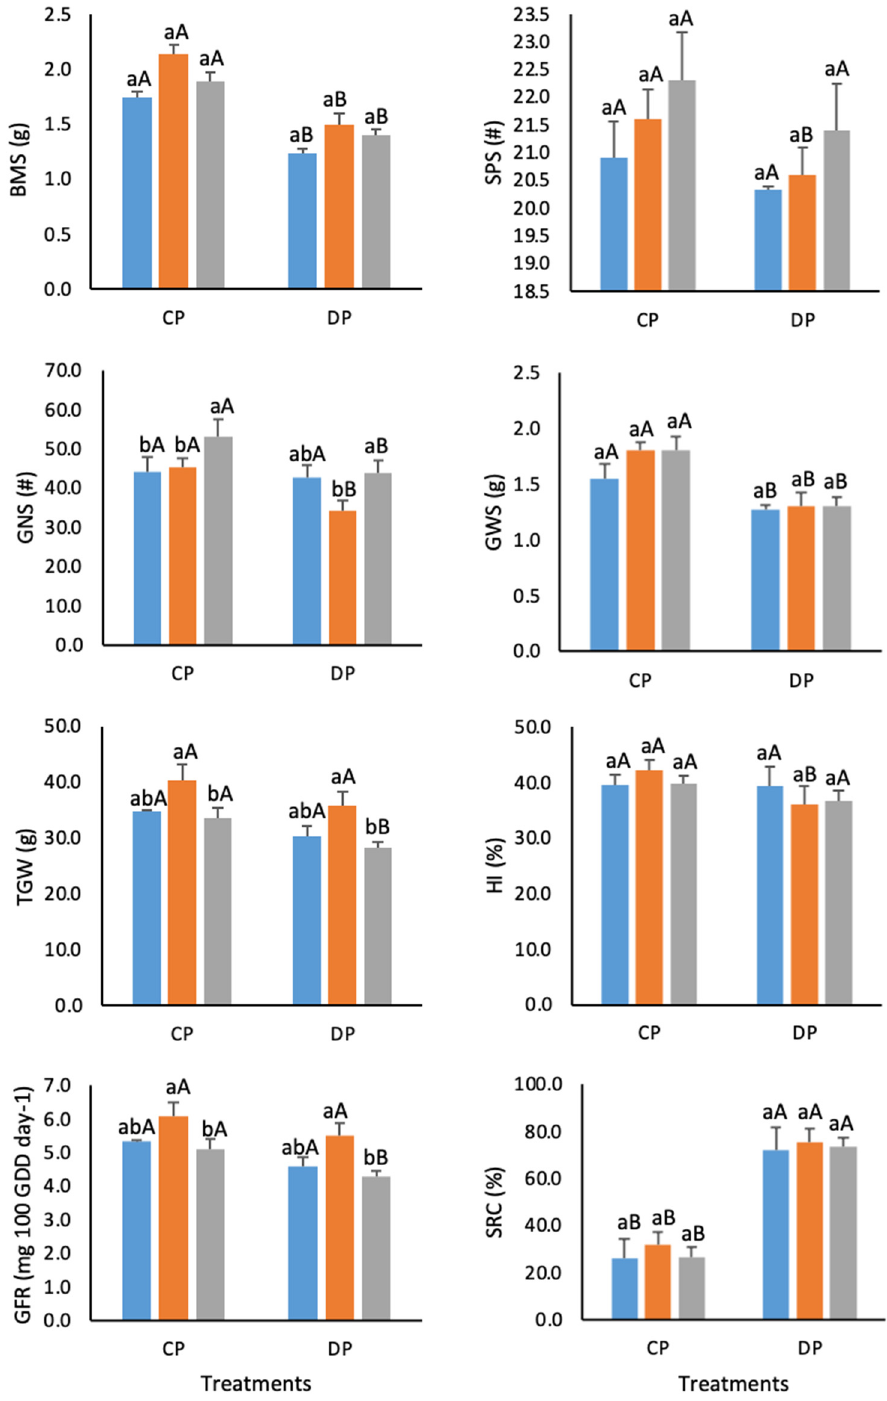
Figure 2. Performance of standard genotypes (STA; blue bars), families (FAM; red bars), and parents (PAR; grey bars) in control (CP) and defoliated plants (DP) across two growing seasons. Different lowercase letters indicate a significant difference between three groups (STA, FAM, and PAR) separately for each treatment (CP and DP); different uppercase letters indicate a significant difference between the two treatments separately for each group at p < 0.05 according to Tuckey’s test. BMS—stem biomass, SPS—number of spikelets per spike, GNS—grain number per spike, GWS—grain weight per spike, TGW—1000-grain weight, HI—harvest index, GFR—grain-filling rate, SRC—stem reserve contribution to GWS.